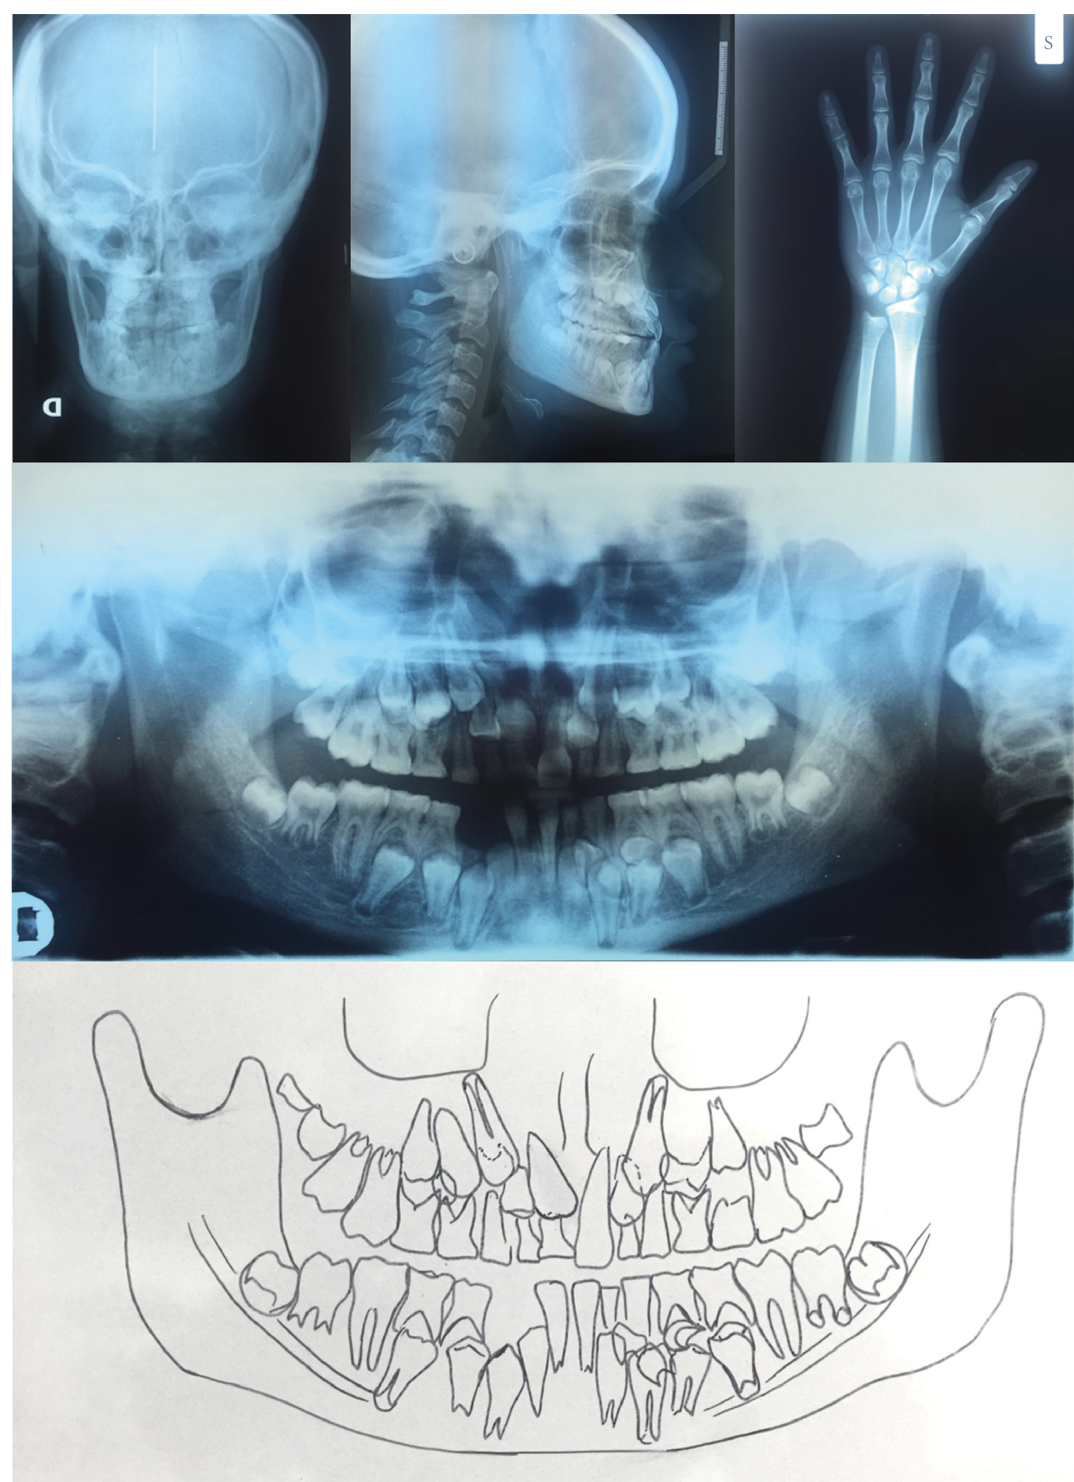
Figure 12: Radiographs of skull and